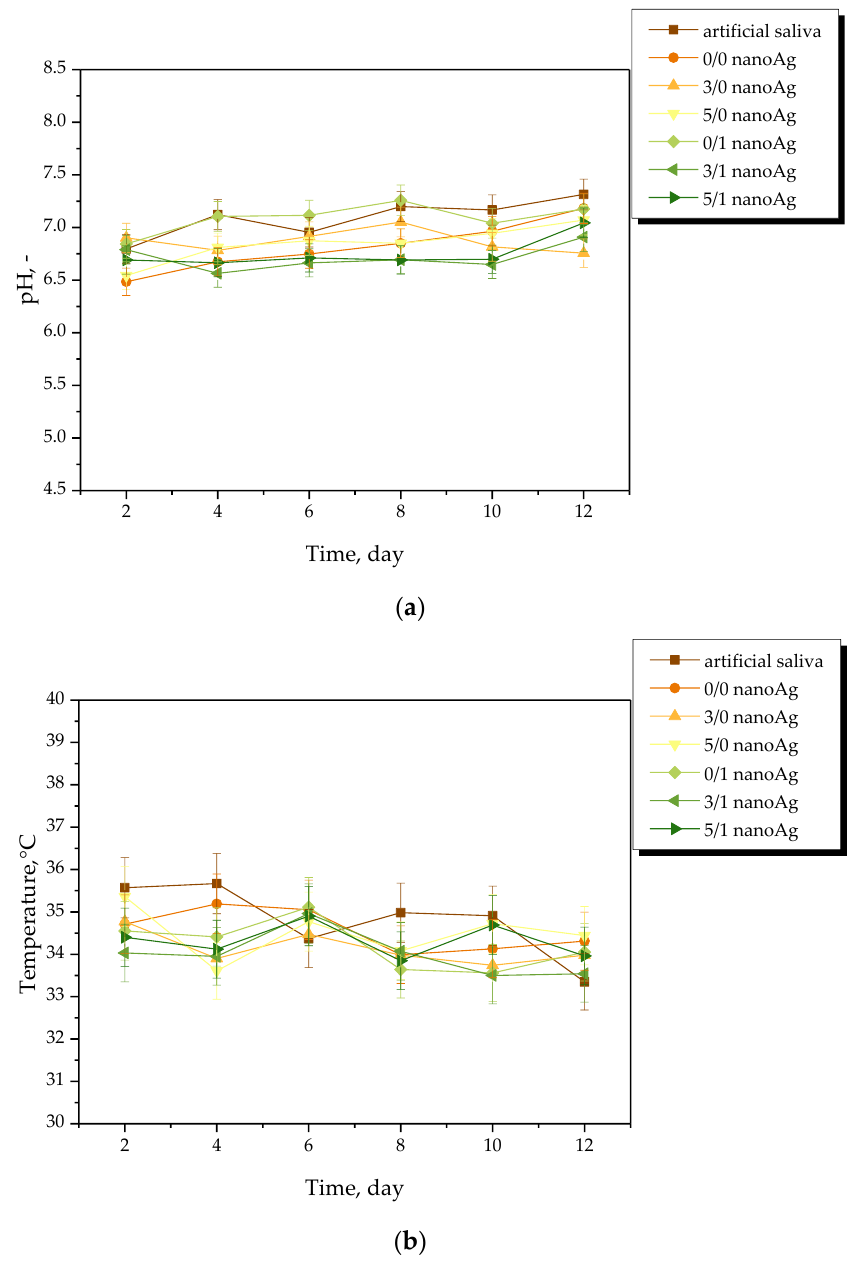
Figure 7. pH ( a ) and temperature ( b ) measurements of artificial saliva during hydrogels’ incubation (n = 3, n — number of repetitions).